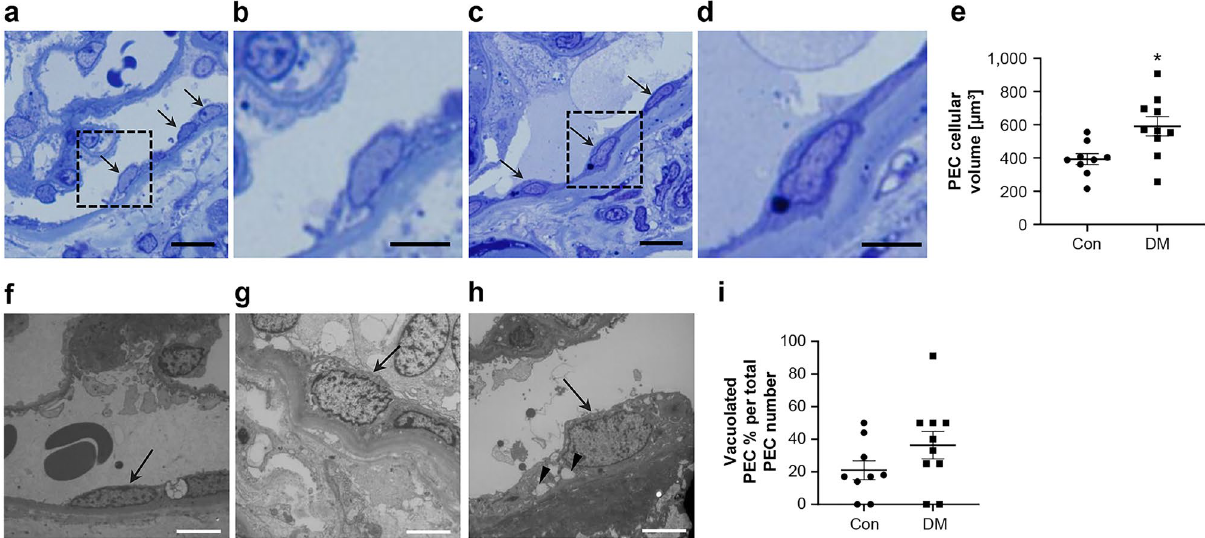
Figure 4. Morphological findings of PECs in diabetic human subjects. (a–d) PECs in human renal biopsy specimens from control patients (Con) (a,b) and patients with diabetes mellitus (DM) (c,d) (plastic-embedded semi-thin section stained with toluidine blue). Arrows indicate PECs. (b,d) The magnified view of the boxed region in (a) and (c) , respectively. (e) Quantification of PECs’ cellular volume in Con and patients with DM. (f–h) Transmission electron microscopic evaluation of the PECs in Con without diabetes (f) and patients with DM (g,h) . (f) An example of a PEC (arrow) is shown to have a flat cell body and a flat nucleus on the BBM in a nondiabetic subject. (g,h) The PECs in patients with DM were enlarged (arrow) and exhibited cytoplasmic vacuolization (arrowhead). Each figure was obtained from corresponding patients in Table 1, ( e ) CO-7, ( f ) DM-1, ( g ) DM-5. (i) Quantification of the ratio of vacuolated PEC number per total PEC number in Con and in patients with DM. Scale Bars: ( a , c ) 10 µm, ( b , d , f – h ) 5